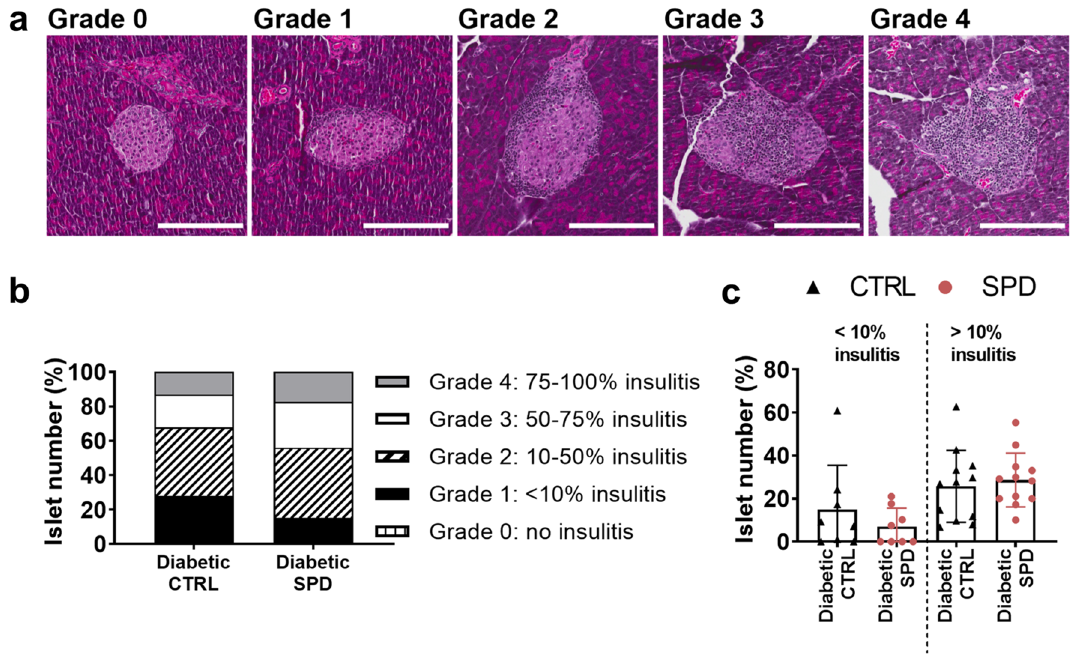
Figure 2. Daily oral spermidine treatment did not alter insulitis in pancreatic islets of female diabetic mice. ( a ) Insulitis grading map: grade 0 (no insulitis), grade 1 (peri insulitis to 10% insulitis), grade 2 (10- 50% insulitis), grade 3 (50- 75% insulitis), grade 4 (75–100% insulitis), scale bar: 200 µm, 20-fold magnification. ( b ) Number of islets per grade normalized to total number of islets in each mouse. ( c ) Percentage of islets having < 10% insulitis and > 10% insulitis analyzed in diabetic ctrl mice and diabetic spd mice in accordance to insulitis grading (2 datapoints per mouse in each group), black triangles show diabetic ctrl mice and red circles show diabetic spd mice. Diabetic ctrl mice (n = 4) and diabetic spd mice (n = 4). Two-way ANOVA with Sidak’s post-hoc test to compare respective grades between ctrl and spd groups and Mann–Whitney U test to compare ctrl and spd groups were used as statistical